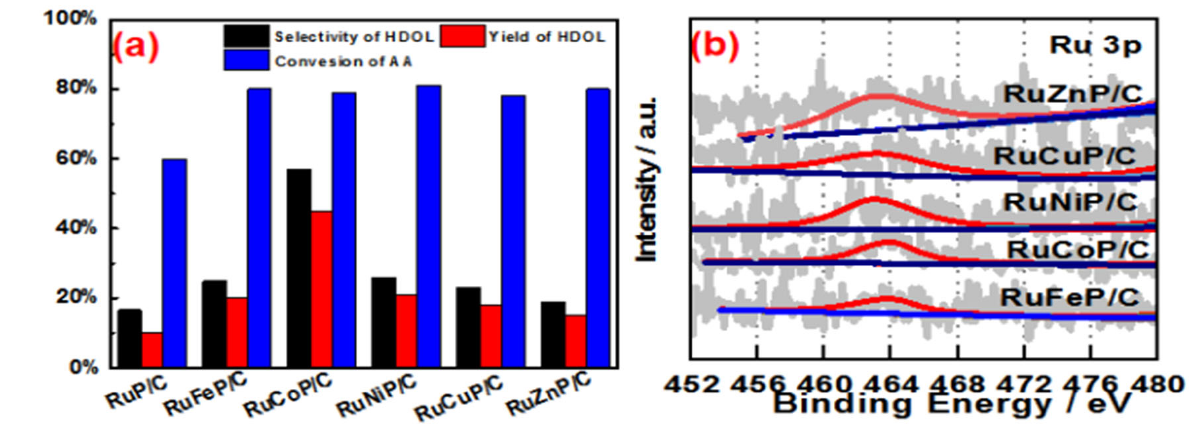
Figure 1. ( a ) Hydrogenating AA to HDOL on the different metal ‐ doped amorphous alloy catalysts at 220 °C with a H 2 pressure of 65 bar. ( b ) Ru 3p3/2 XPS spectra of the different metal ‐ doped alloys.